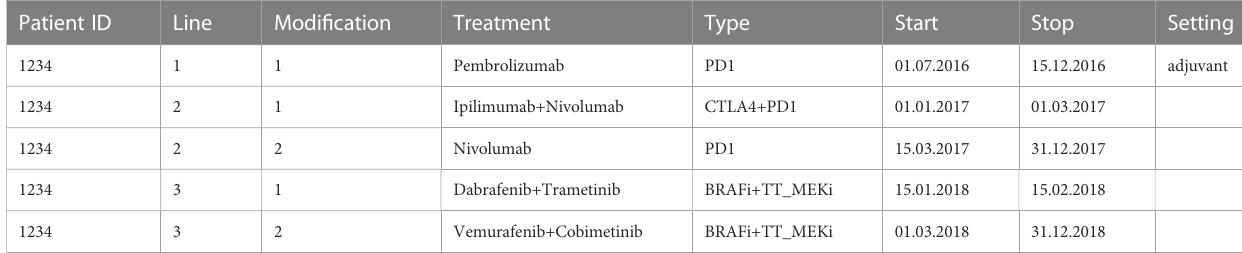
TABLE 1 Oncological treatment format in